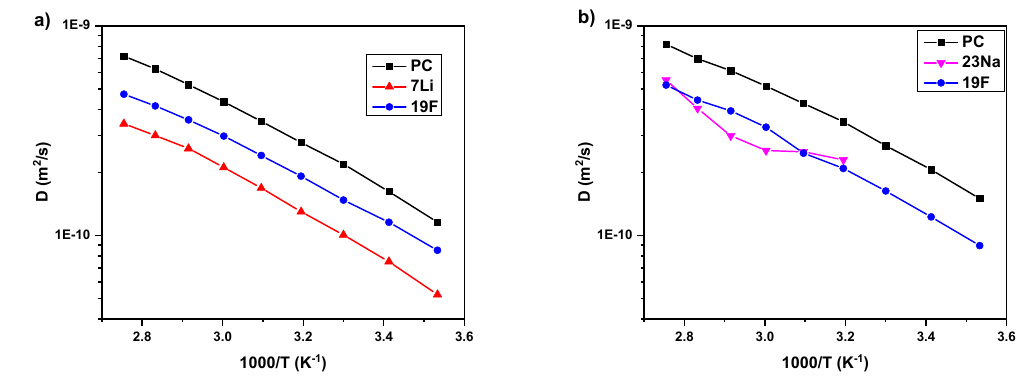
Figure 4. Temperature dependence of NMR self ‐ diffusion coefficients for the LiTFSI_0%G ( a ) and NaTFSI_0%G ( b ) electrolytes (without PAMAM). The solid lines are guides for the eye.